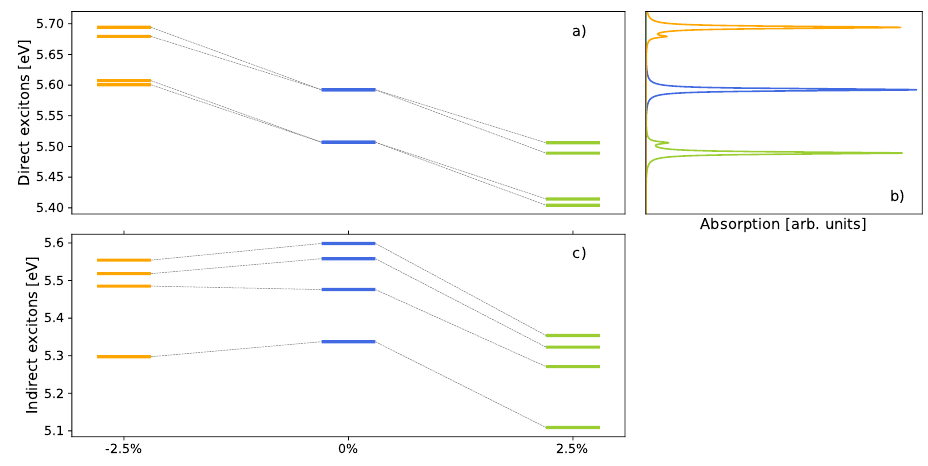
Figure 7: [ Color online ] In panel ( a ) we report the energy of the lowest direct ex- citons with respect to strain, and in panel ( b ) the corresponding absorption spectra. In panel ( c ) the lowest indirect excitons vs strain are reported. As in the previous Figures, blue lines are at equilibrium, green lines at 2.5% stretch and orange lines at 2.5%